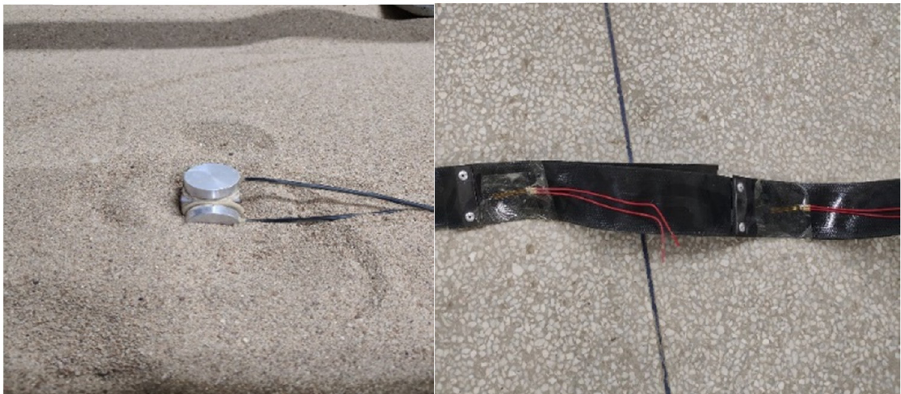
0.00.20.40.60.81.0